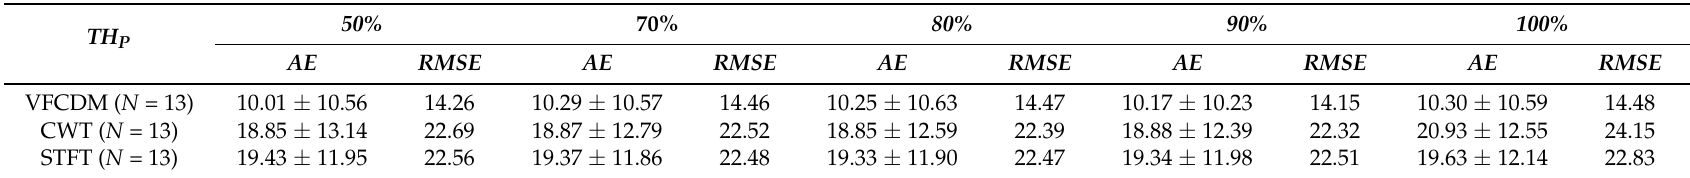
Figure 5. Absolute error distribution of FEV 1 /FVC from COPD patients according to TH P based on ( a ) VFCDM, ( b ) CWT, and ( c ) STFT. Table 4. COPD patients’ absolute errors (AE) and RMSEs of FEV 1 /FVC ratio according to TH P for VFCDM, CWT, and STFT methods.